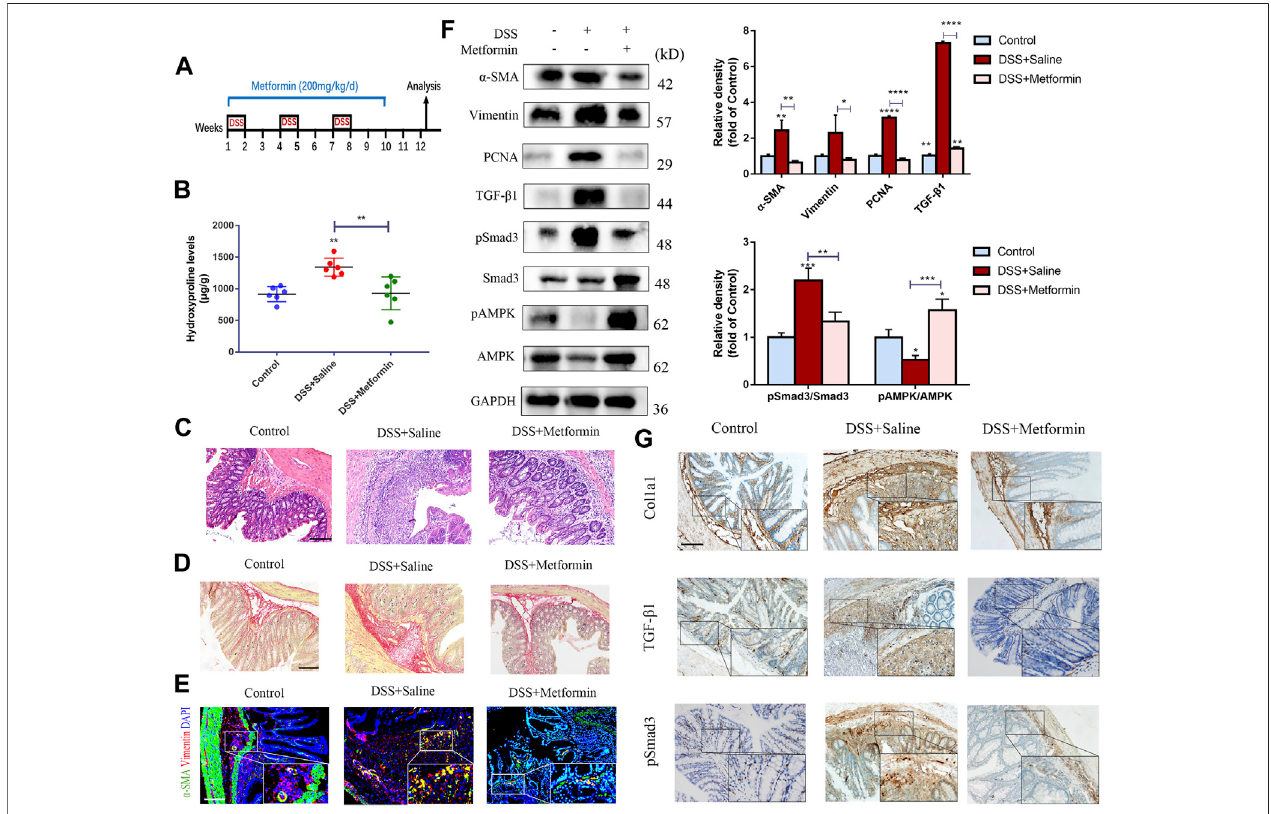
FIGURE 2 | Preventive metformin application decreases intestinal fi brosis in DSS mice model. (A) Mice experimental protocol of DSS colitis. (B – D) Colon tissues wereanalyzed by (B) Hydroxyproline assay, (C) H&E stainingor (D) Sirius Redstaining( n = 6/group). (E) IF for α -SMAand Vimentinwasanalyzed incolon slicesof three groups ( n = 6/group). (F) Representative pictures of western blot indicating changesof thekey fi brotic markers and proteins in TGF- β 1/Smad3 signaling after metformin treatment. Quantitative analyses of western blot ( n = 3 independent experiments) were shown (G) Representative images of immunohistochemical staining for Col1a1, TGF- β 1 and pSmad3 in colon specimens. Scale bars, 100 μ m. Quantitative results were analyzed by one-way ANOVA test. * p < 0.05; ** p < 0.005; *** p <